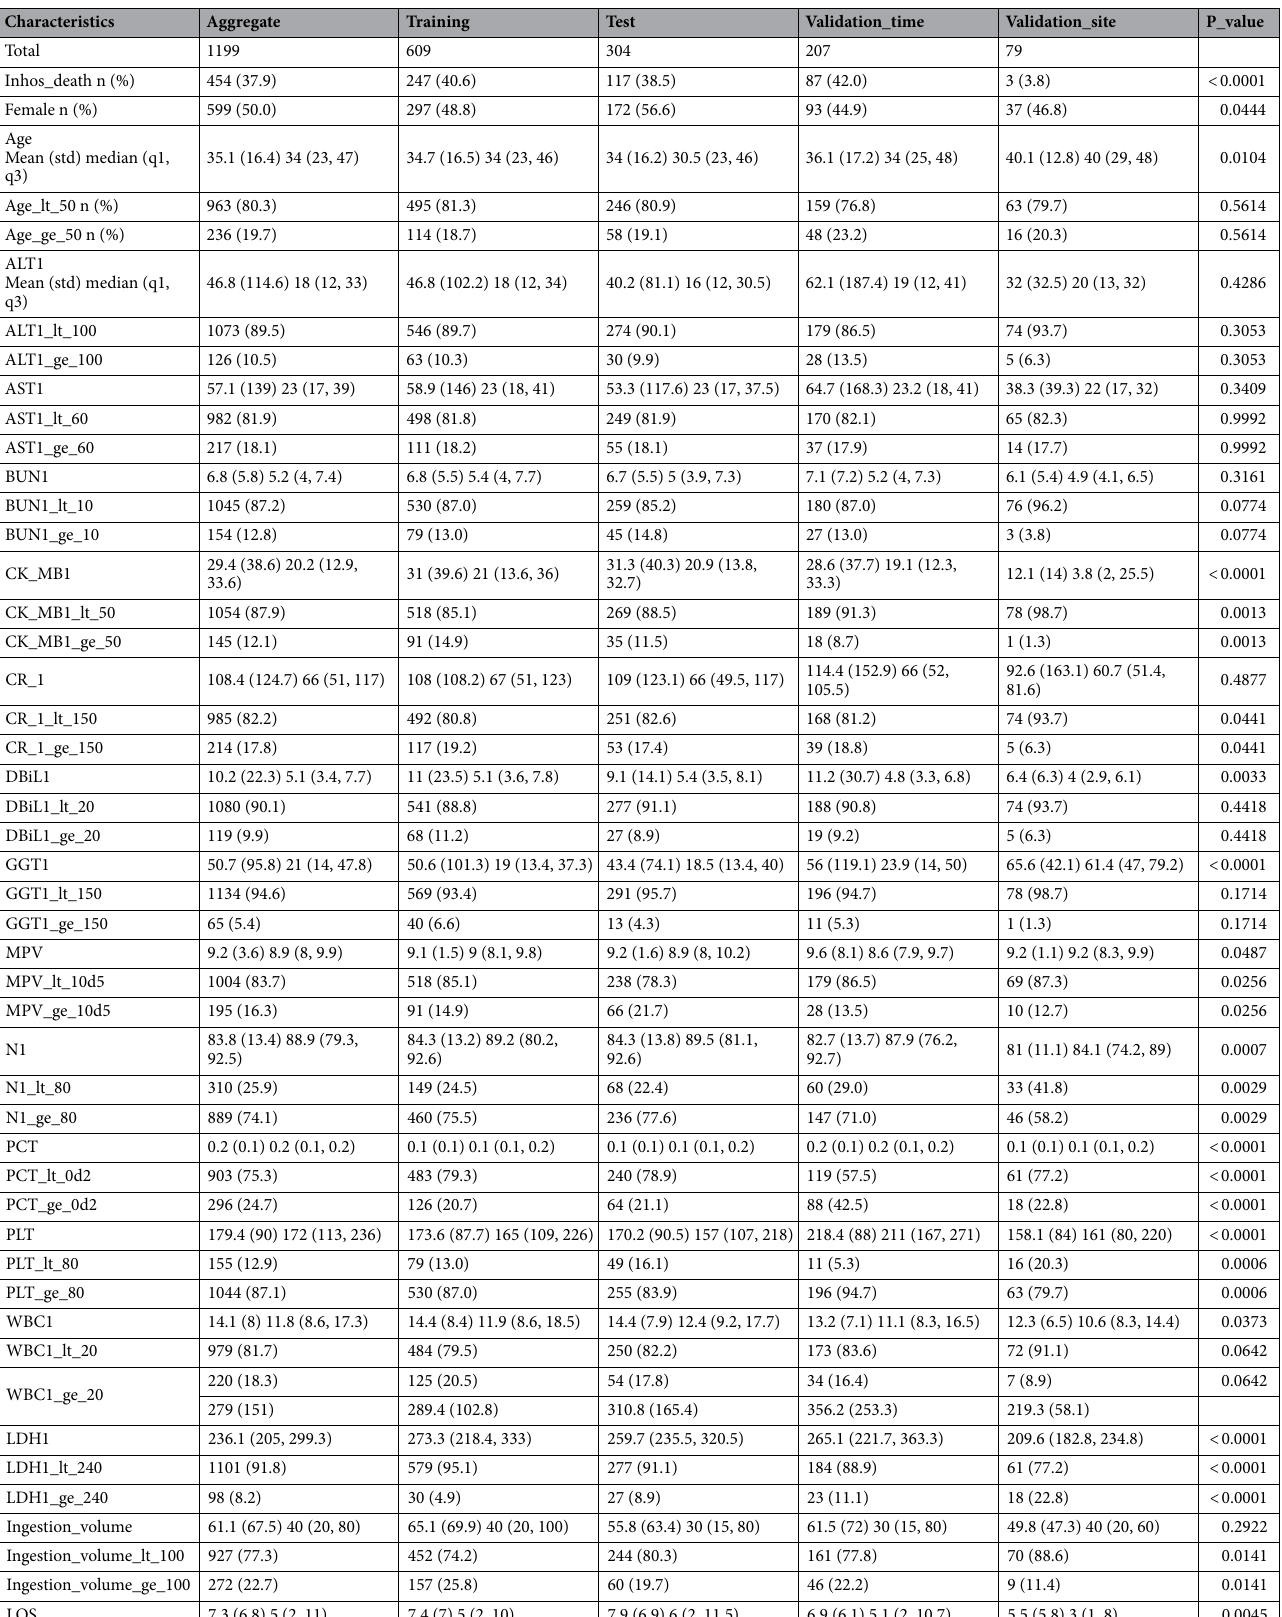
Table 1. Patient characteristics by sample groups. MPV mean platelet volume, PCT procalcitonin, GGT gamma-glutamyl transferase, CR